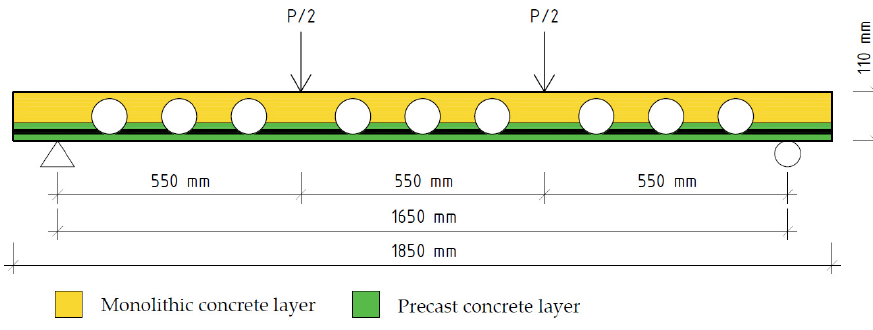
Figure 6. Scheme for the simulated slab.